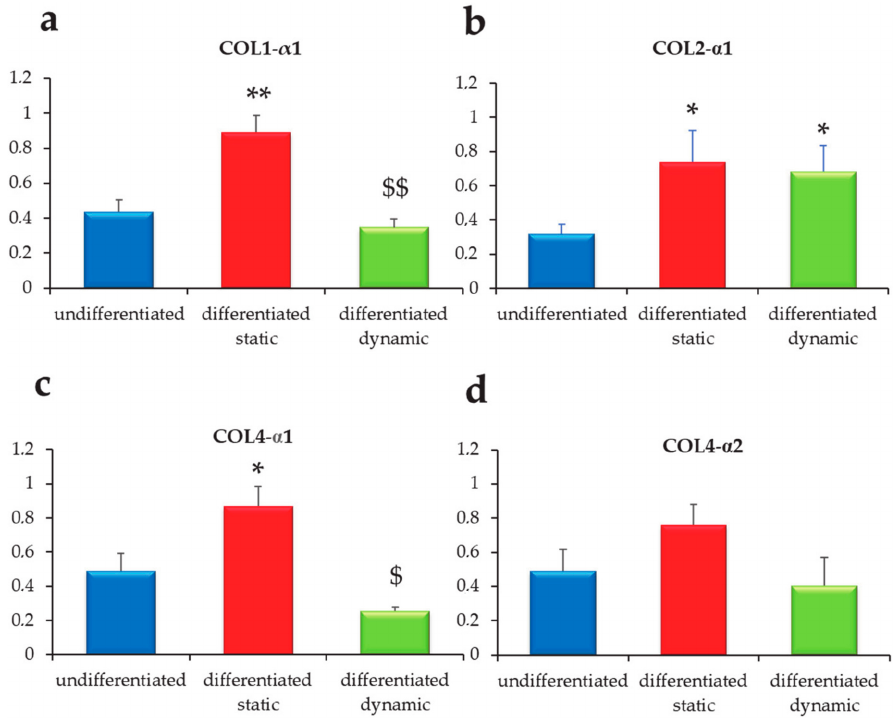
Figure 2. Collagen gene expression analysis performed on hMSC / *PCL constructs for the following genes: ( a ) Col1- α 1; ( b ) Col2- α ; ( c ) Col4- α 1; and ( d ) Col4- α 2: ( a – d ) Statistical significance: * = p < 0.05; ** = p < 0.01 vs undi ff erentiated; $ = p < 0.05; $$ = p < 0.01 vs di ff erentiated statically cultured hMSC / *PCL constructs.